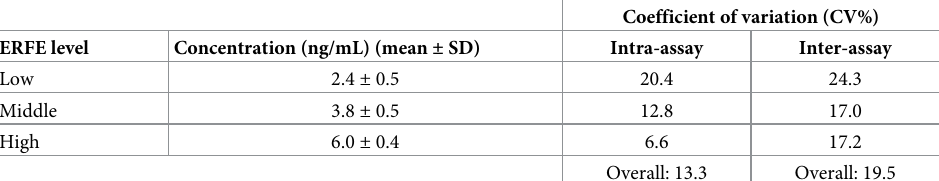
Table 1. Three-level precision.